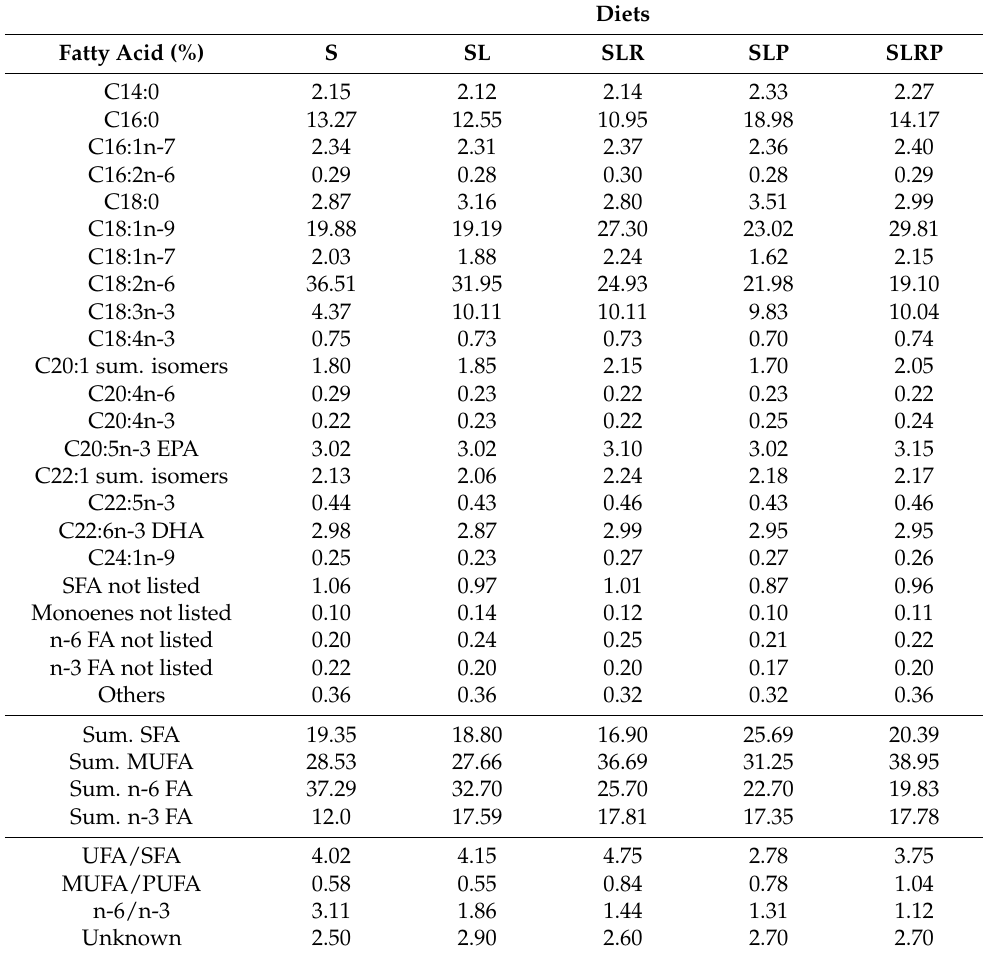
Table 2. Dietary fatty acid profile of the experimental